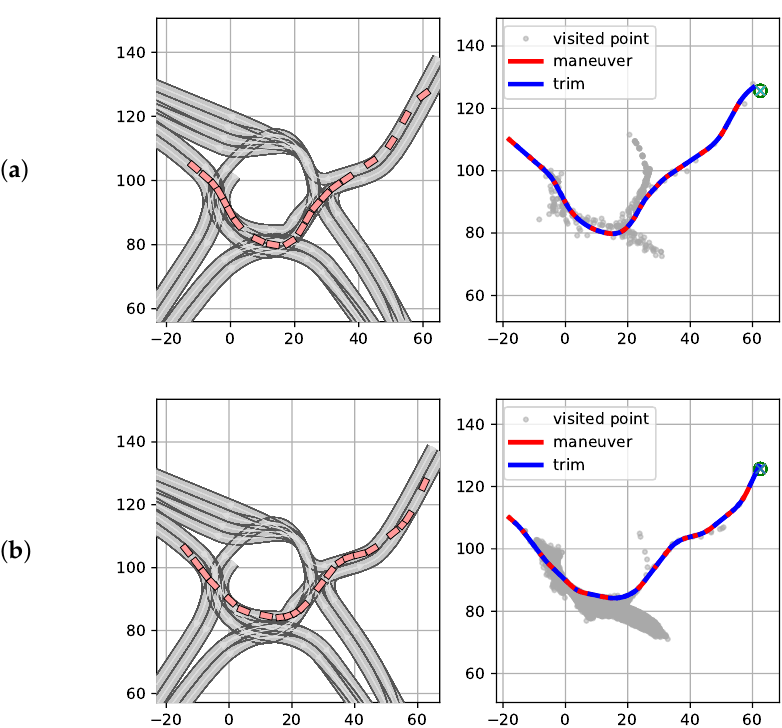
Figure 13. Trajectories for the automaton with 21 trims: ( a ) handcrafted; ( b ) extracted.